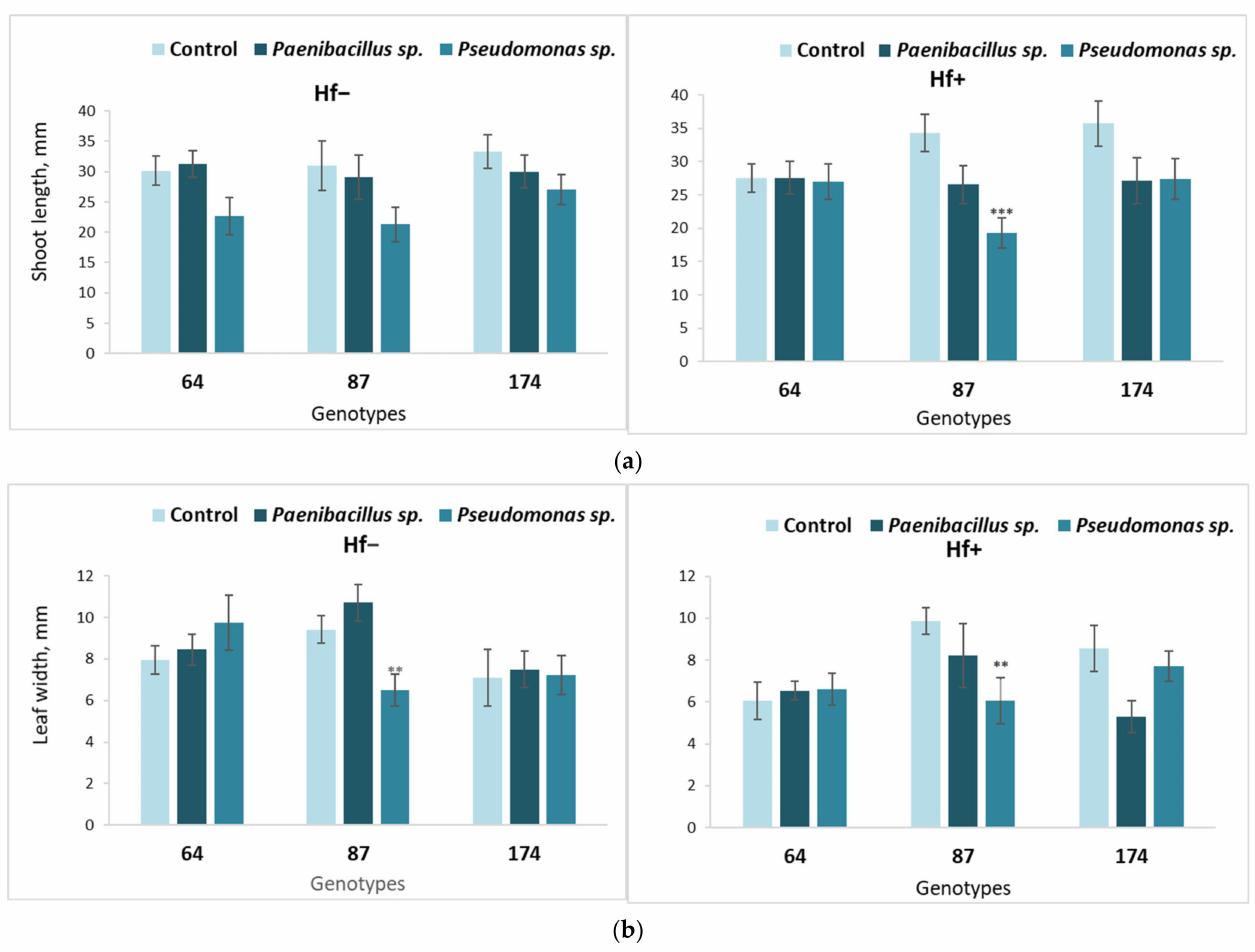
Figure 6. Average shoot length ( a ) and leaf width ( b ) of different F. excelsior genotypes (64, 87 and 174), of which explants were first cultured on the nutrient medium inoculated with Paenibacillus sp. or Pseudomonas sp. bacteria, then transferred onto fresh nutrient medium, either sterile (‘Hf − ’) or inoculated with the fungus H. fraxineus (‘Hf+’). Statistically significant differences from the control variant, which was not treated with bacteria during the first culture stage, are indicated (for each genotype separately): ** p < 0.01; *** p <